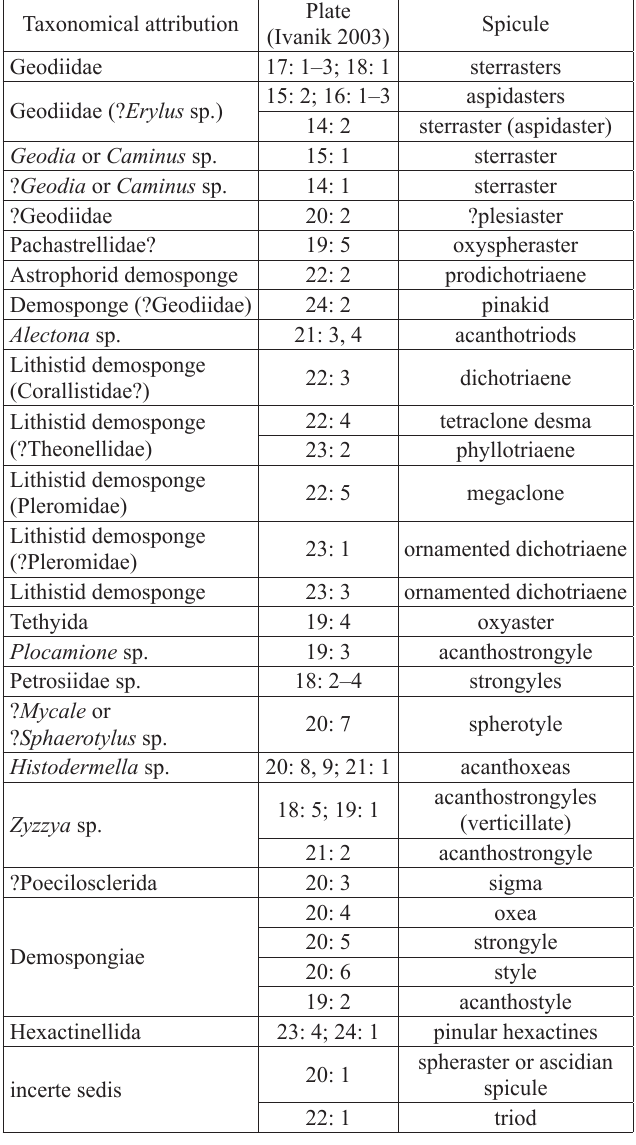
Table 2. Taxonomic affinity of spicules from the East-European Plat- form and adjacent regions illustrated by Ivanik